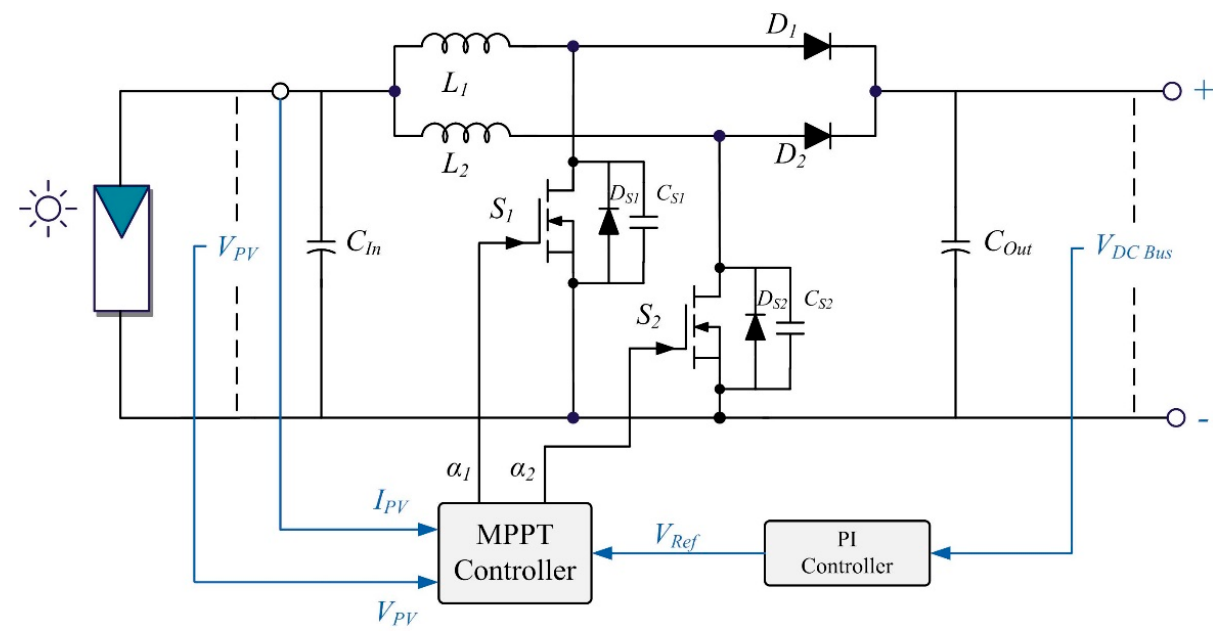
Energies 2022 , 15 , x FOR PEER REVIEW 6 of 25 Figure 1. Proposed two − phase IBC and block diagram of MPPT controller. Figure 1. Proposed two − phase IBC and block diagram of MPPT controller.